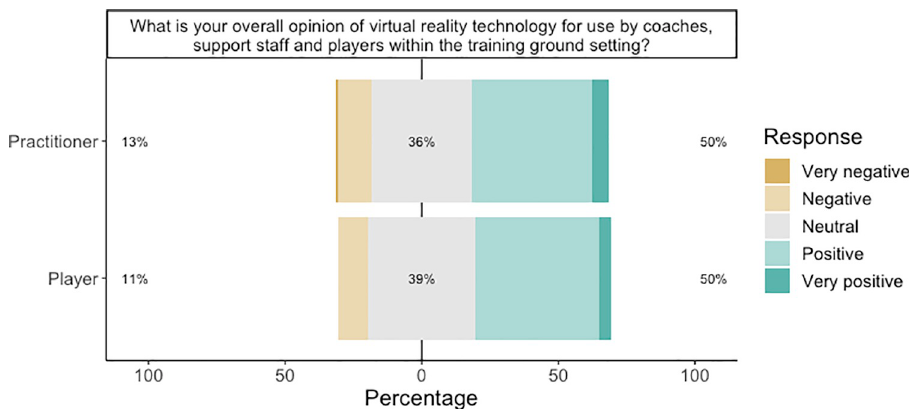
Fig 5. Responses by practitioners and players to a statement regarding the overall opinion of VR being used within the training ground setting. Percentages indicate overall negativity, neutral and overall positivity, from left to right